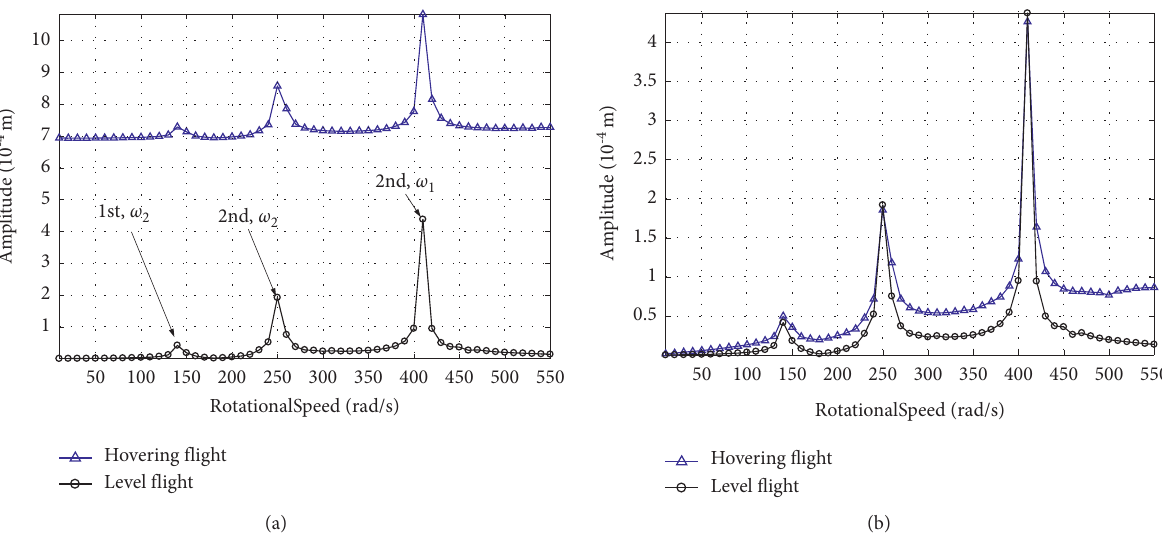
Figure 7: Vibration response of disk 4 with respect to rotational speed. (a) Horizontal direction. (b) Vertical direction.